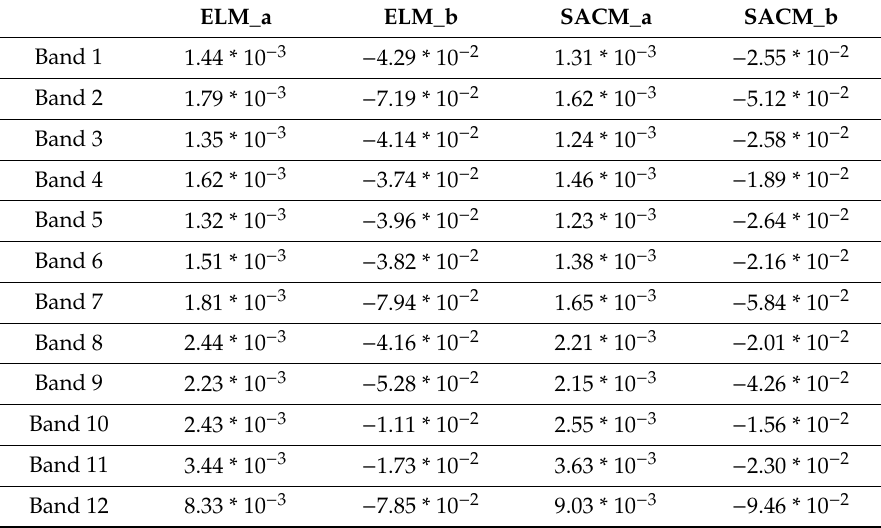
Figure 8. The images of the study area before and after calibration. Table 5. The calibration coefficients of each band.